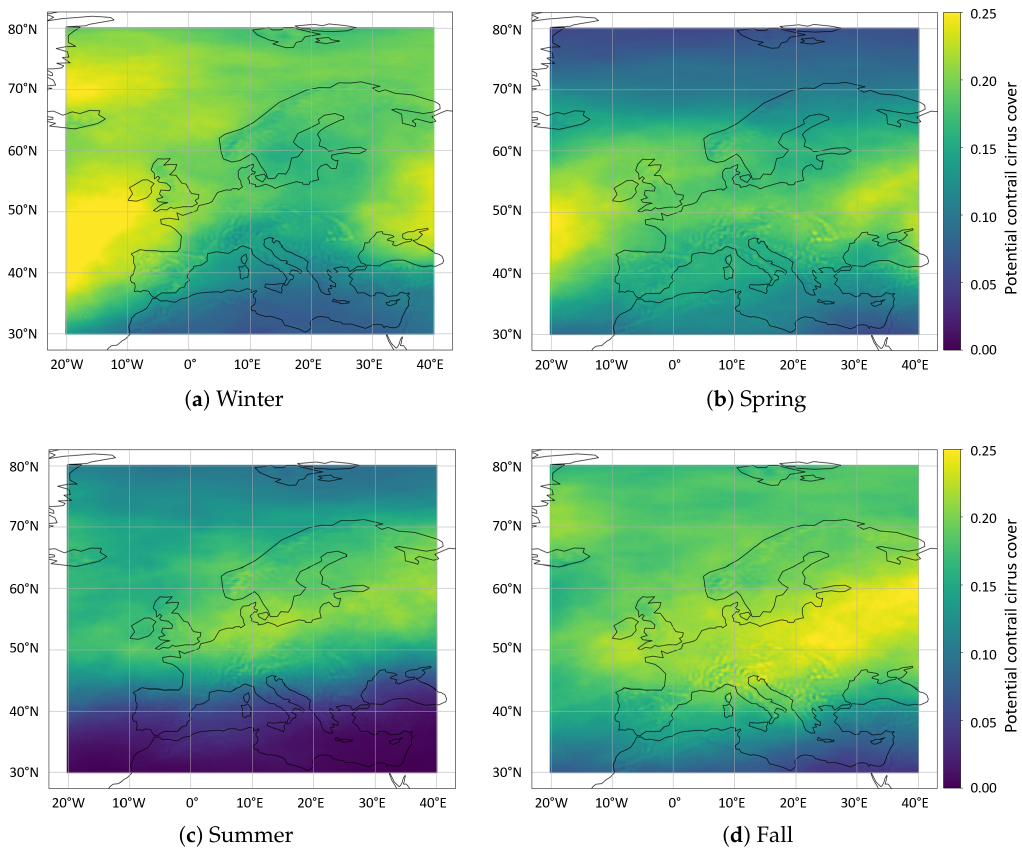
Figure 5. Seasonality in contrail formation and persistence, plotted over Europe at 250hPa using a threshold for the relative humidity of 95%. The highest potential contrail cirrus cover appears in winter ( a ) and fall ( d ) due to cold air temperatures and high relative humidity in fall. In spring ( b ), persistent contrails are limited by the low relative humidity in the north, and in summer ( c ), by the high air temperatures in the